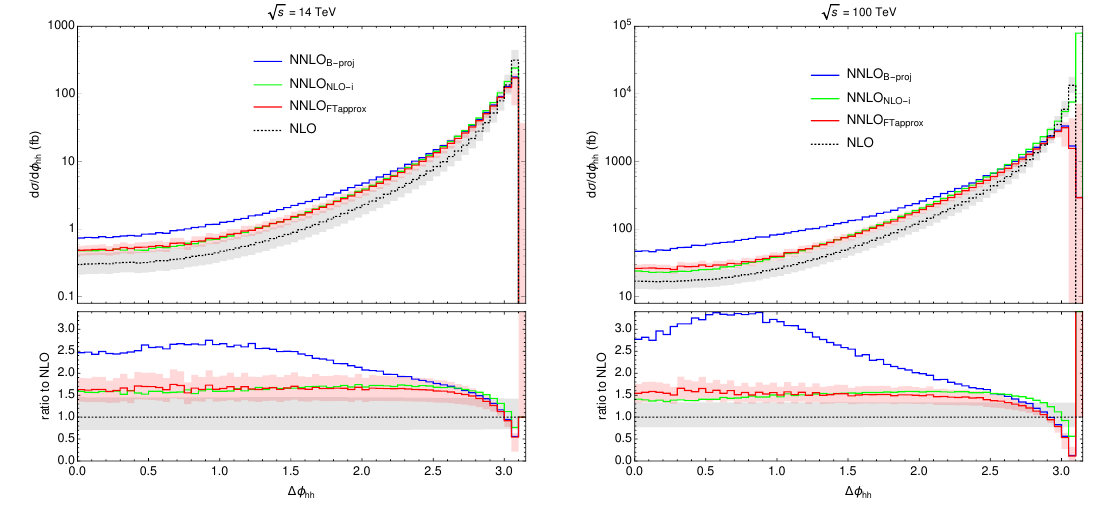
Figure 8 . Azimuthal angular separation between the two Higgs bosons at 14 TeV (left) and 100 TeV